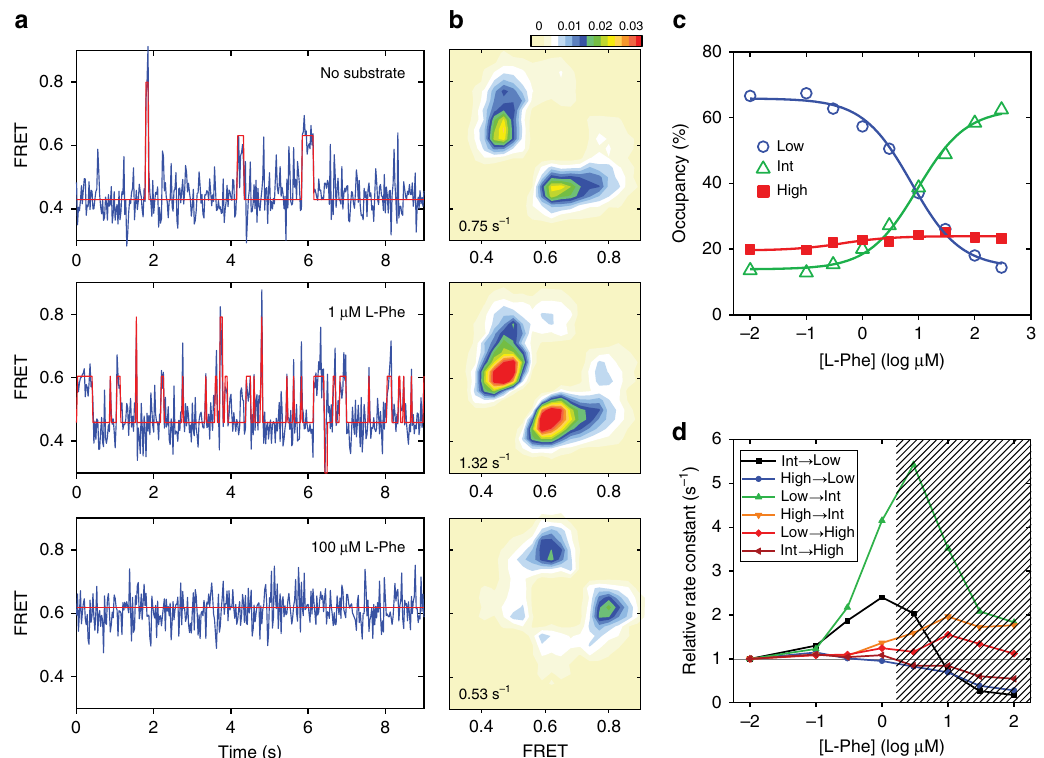
Fig. 1 Effect of L -Phe on LeuT WT dynamics. a Intracellular-labeled LeuT WT-7C/86C was imaged with single-molecule fl uorescence resonance energy transfer (smFRET) in the presence of 5 mM Na + and in the absence of substrates (top), in the presence of 1 μ M L -Phe (middle) or in the presence of 300 μ M L -Phe (bottom). Shown are representative smFRET traces (blue) with state assignment traces (red). b Transition density contour plots showing the mean FRET value in the dwell just prior to (bottom axis) and just after (left axis) each transition between distinct FRET states (high-FRET state with a FRET ef fi ciency of ~0.8, intermediate-FRET state with a FRET ef fi ciency of ~0.6 and low-FRET state with a FRET ef fi ciency of ~0.4), summed into a histogram. The average transition rate between states is given at the bottom left of each panel. Transitions per second rate scale is shown on top. c Ensemble-averaged occupancy in the low- (blue circles), intermediate- (green triangles) and high-FRET states (red squares) were fi tted to dose-response functions with the Hill coef fi cients fi xed at 1.0 and EC 50 of 5.1 μ M (lines). d Rate constants for each transition type from experiments conducted in the presence of the indicated concentration of L -Phe (bottom axis), relative to the absence of substrate. Shaded area indicates regime in which time averaging obscures transitions, resulting in erroneous rate estimates. Source data are provided as a Source Data fi L -Phe binding to LeuT results in an apparent stabilization of a functionally relevant, inward-open conformation on the pathway to intracellular release of Na + prior to full inward opening.